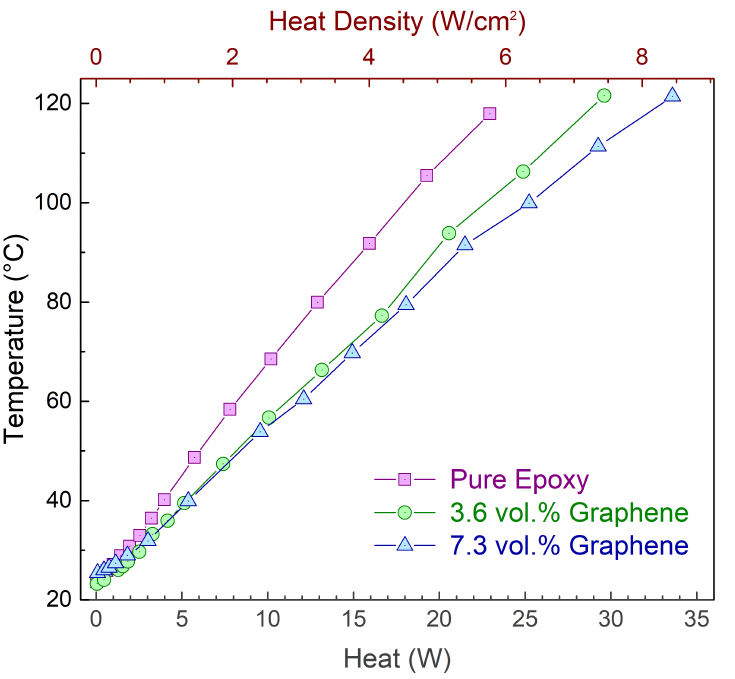
Figure 4. Measured thermal equilibria for each experimental vehicle with different TIM FLG concen- trations at different heating coil power levels.